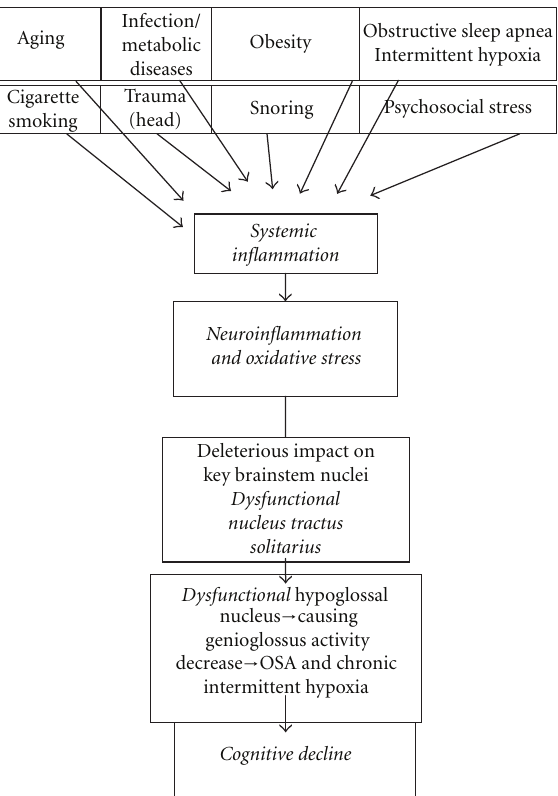
Figure 1: Schematic representation of the pathogenesis of cognitive decline in patients with sleep disordered breathing. Several risk factors upregulate proinflammatory cytokines and induce systemic inflammation. The latter then promotes neuroinflammation which augments further inflammation; this has a negative impact on neu- ronal, glial, and vascular endothelial cell functions. Inflammation, intermittent hypoxia, and oxidative stress provide a rich milieu causing the NTS inflammation and dysfunction. Being a central hub for processing disparate a ff erents and owing to its widespread projections in the CNS, the dysfunctional NTS would negatively impact several key brain foci and their physiological functions. Dysfunctional NTS and hypoglossal nuclei would cause genioglos- sus dysfunction resulting in pharyngeal obstruction/collapse. This leads to snoring, OSA, intermittent hypoxia, and hypoxemia. Thus, neuroinflammation and sleep apnea are major contributing factors that may cause neuronal degeneration and provoke cognitive